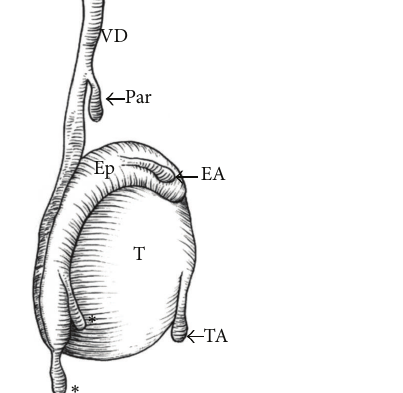
Figure 1: Testicular appendages; VD: vas deferens; T: testicle; Ep: epididymis; Par: organ of Giraldes; EA: epididymal appendage; TA: testicular appendage; ∗ : aberrans of Haller. Source: Favorito et al. [2].